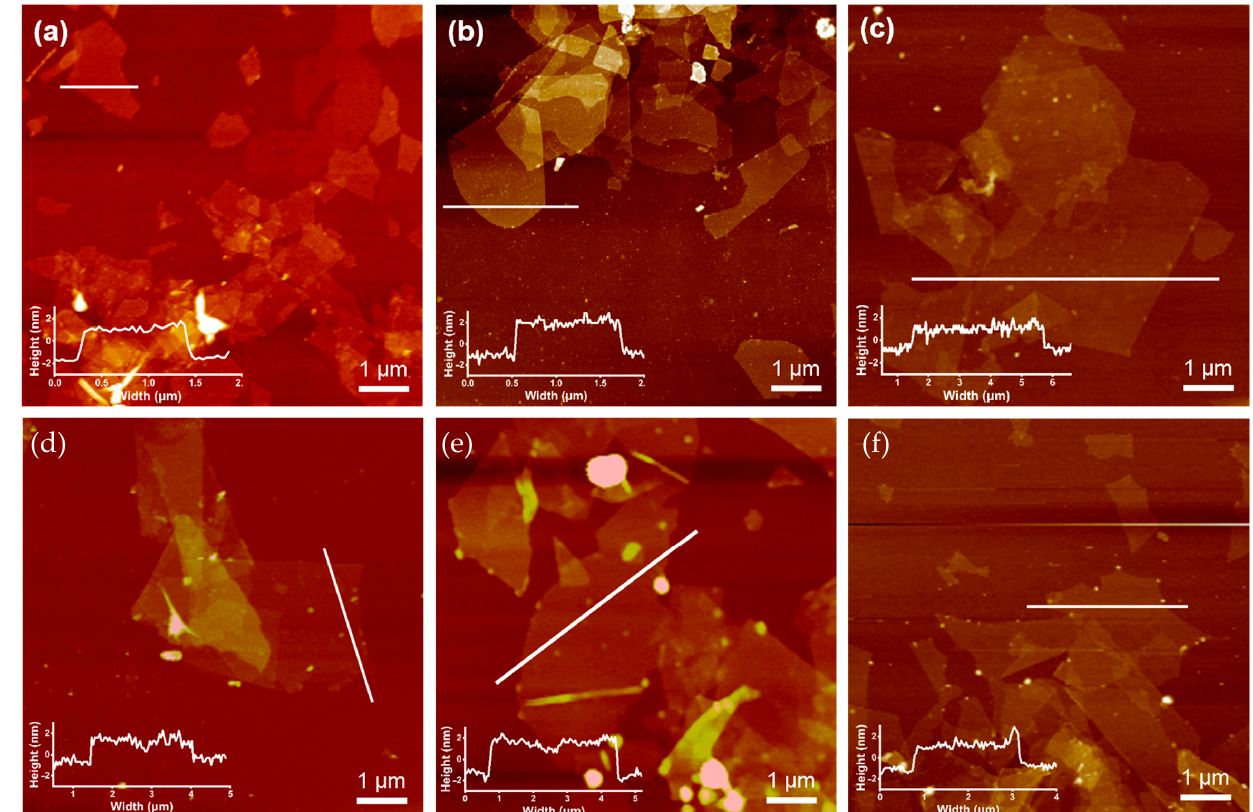
Figure 5. The AFM images of CU-CS Ti 3 C 2 T x MXene: ( a ) 1, ( b ) 2, ( c ) 3, ( d ) 4, ( e ) 5 and ( f )